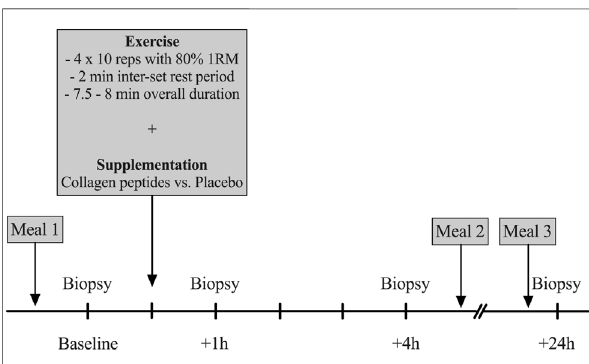
FIGURE 1 | Overview on the experimental design (1RM = One repetition maximum, reps = repetitions).